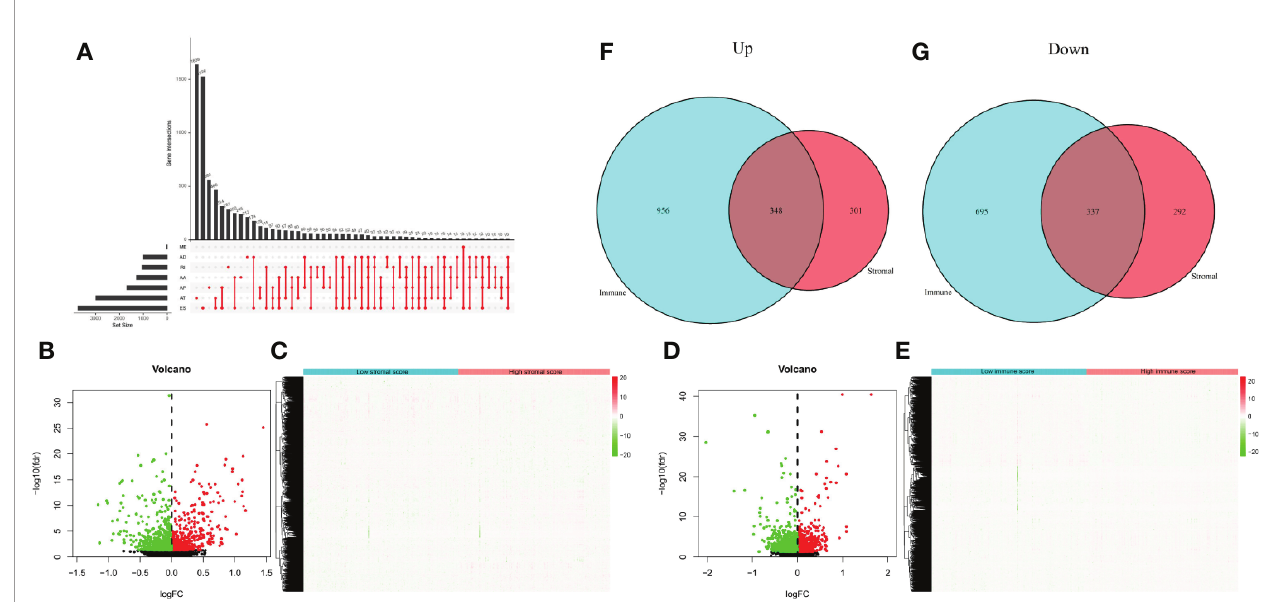
FIGURE 3 | DEAS events between high and low stromal/immune scores groups. (A) The UpSet plot of intersections between AS events and the corresponding gene intersections. The volcano plots (B, D) and heatmaps (C, E) of DEAS events between the high and low stromal/immune scores groups. The up-regulated (F) or down-regulated (G) DEAS events in both stromal score and immune scores groups by Venn diagram.